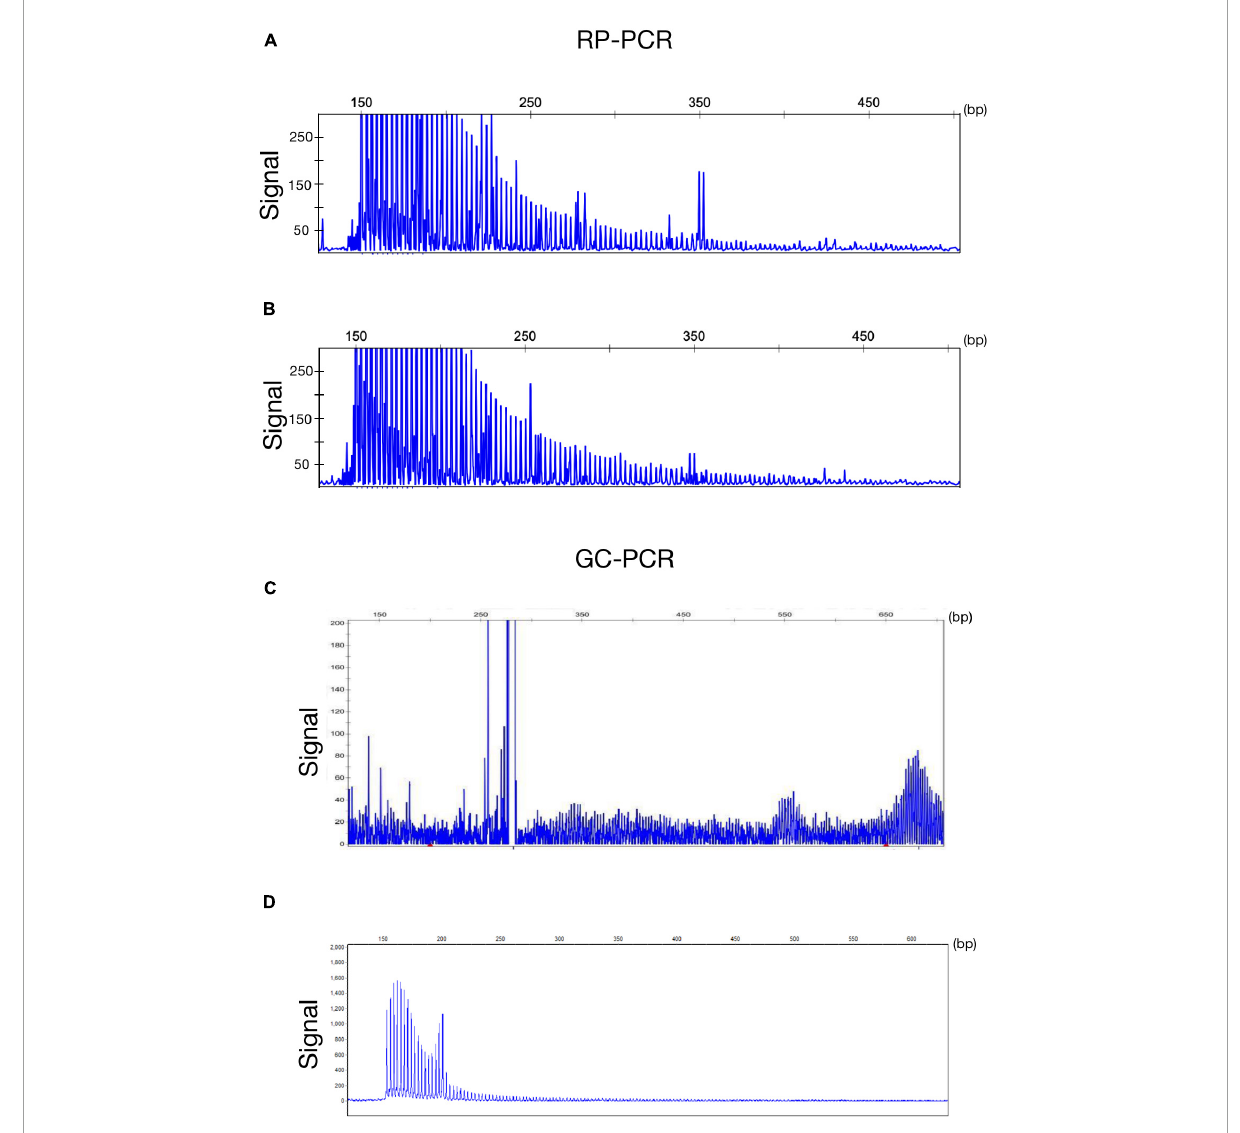
FIGURE2 Genetic findings of NIID. Electropherogram of repeat-primed PCR (RP–PCR) analysis shows a saw-tooth tail pattern of the repeat expansion in NOTCH2NLC -affected individuals (A,B) . Electropherogram of amplicon length PCR (GC–PCR) analysis shows the number of GGC repeats in NIID-affected individuals (C,D)